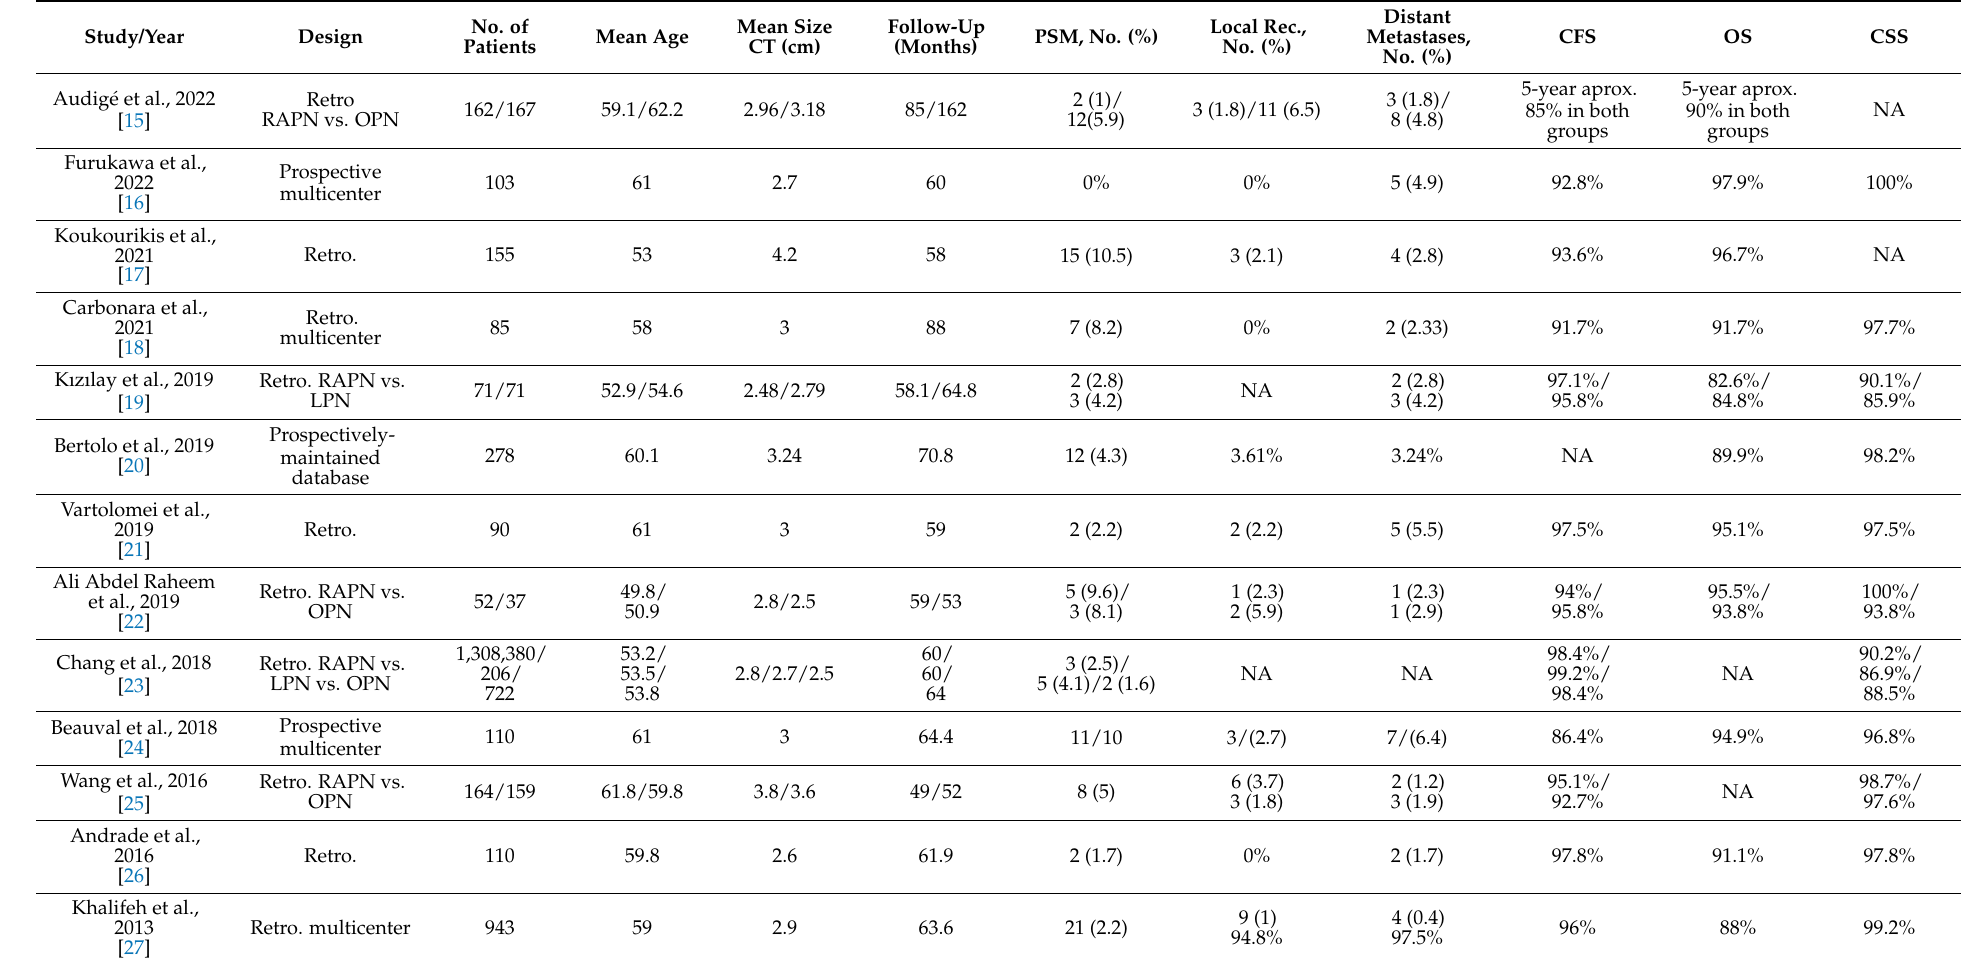
Table 1. Robot assisted partial nephrectomy series with 5 year reported oncologic